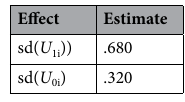
Table 6. Estimated standard deviations of RBE model random effects.